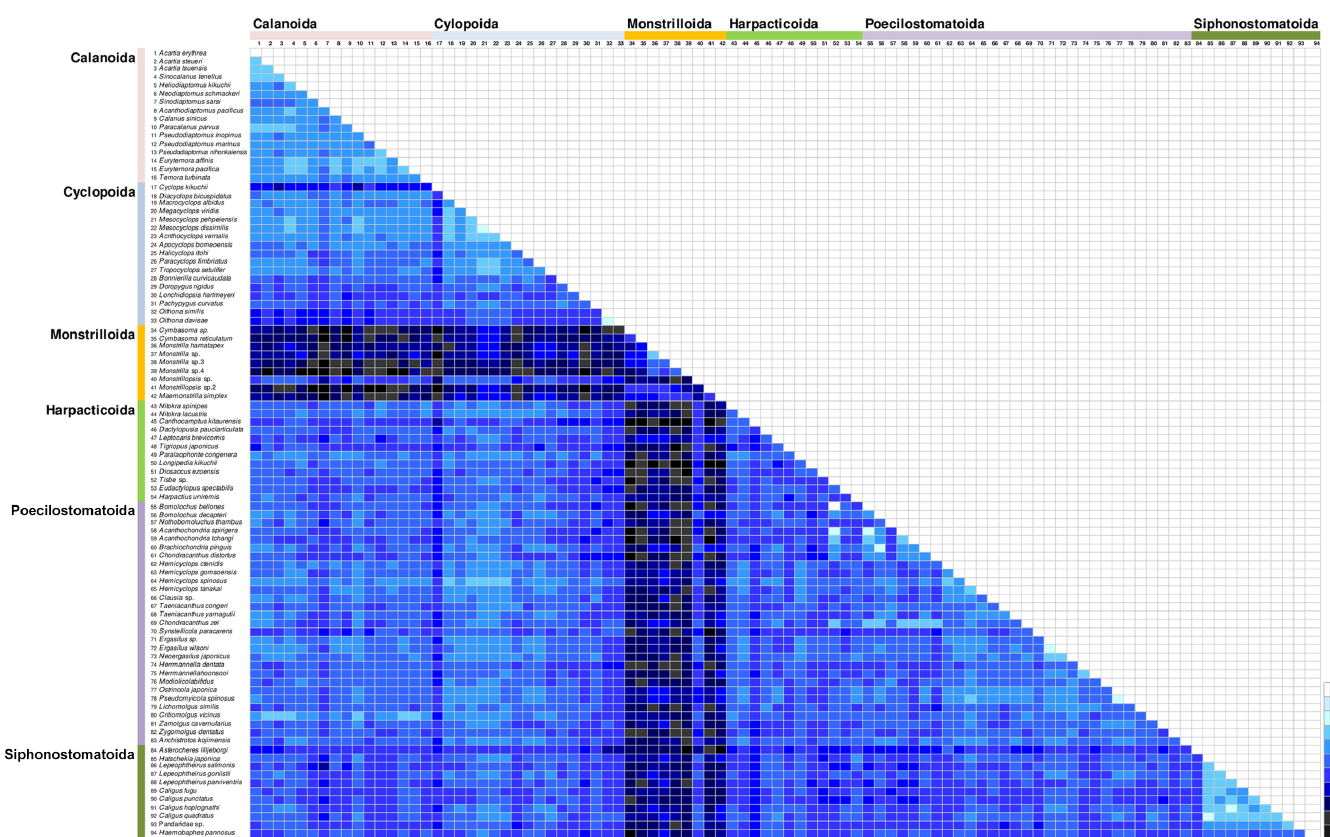
Fig 4. Color heatmap showing distribution of pairwise genetic distances estimated from nucleotide sequences of COI for 94 copepod species covering the six orders based on the Kimura-2-parameter (K2P)